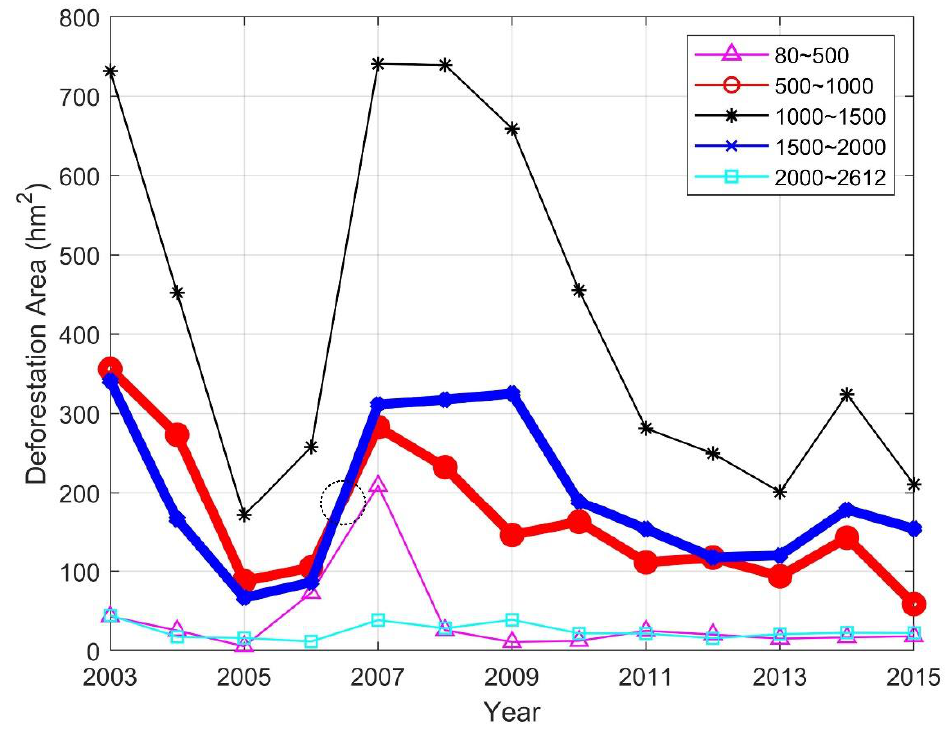
Figure 8. Comparison of time series deforestation area for each elevation segment. The “golden cross” is shown by the dotted circle.